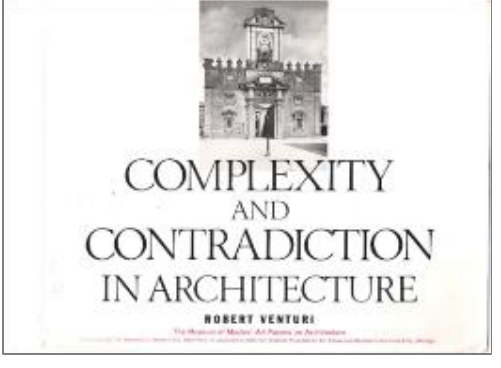
Figure 12 Complexity and Contradiction in Architecture (Venturi, R.,